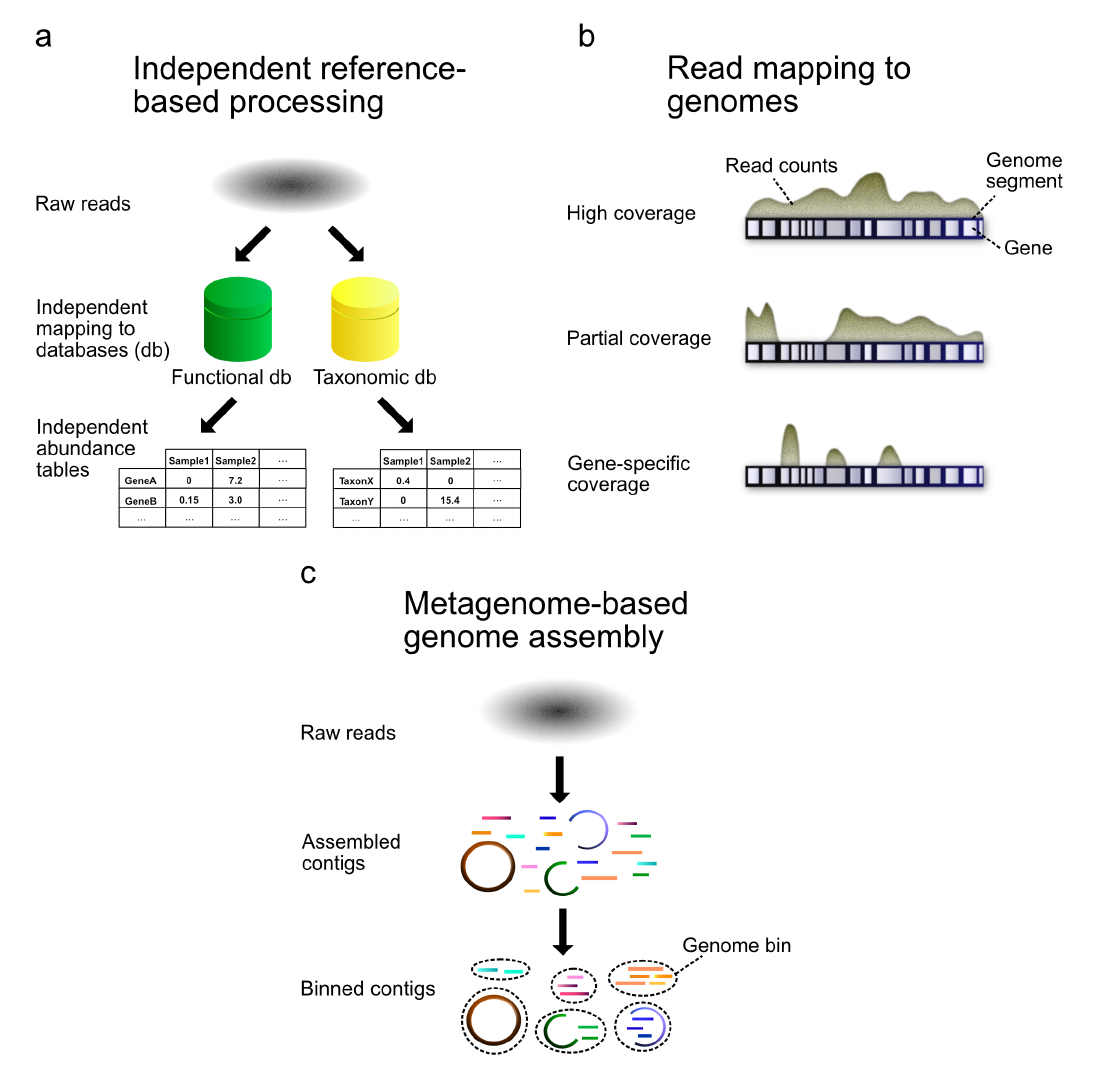
Figure 1: Key approaches for generating joint taxonomic and functional data from metagenomics sequencing data . (a) Read-based processing of metagenomics data to generate functional and taxonomic abundance tables independently. (b) Read mapping to genome sequences can be used to infer the presence of a taxon based on read coverage.